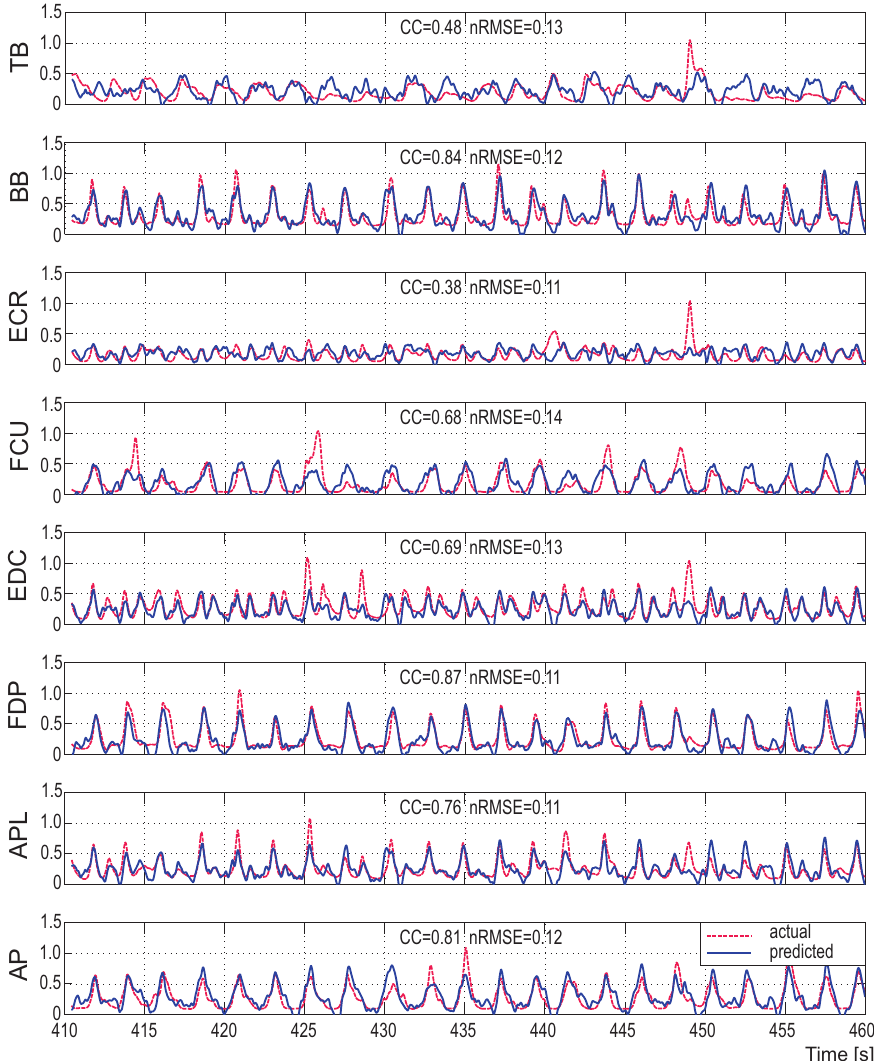
Figure 5. Example of muscle activity prediction in a continuous time series from monkey B. Dotted lines are actual muscle activities from EMG signals and solid lines are predicted muscle activities from ECoG signals over a 50 s time interval. Both lines were normalized to the ranges of actual muscle activities. The normalized root mean square error ( nRMSE ) and correlation coefficient (CC) are also shown.